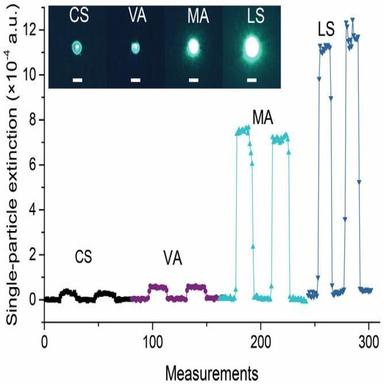
Typical single-particle extinctions of four different materials measured by the OT-CRDS at 308 nm. The images in the inset are from single optically trapped particles of carbon sphere (CS), volcanic ash (VA), Mars analog (MA), and lunar simulant (LS). The scale of the bar is 20 μm.